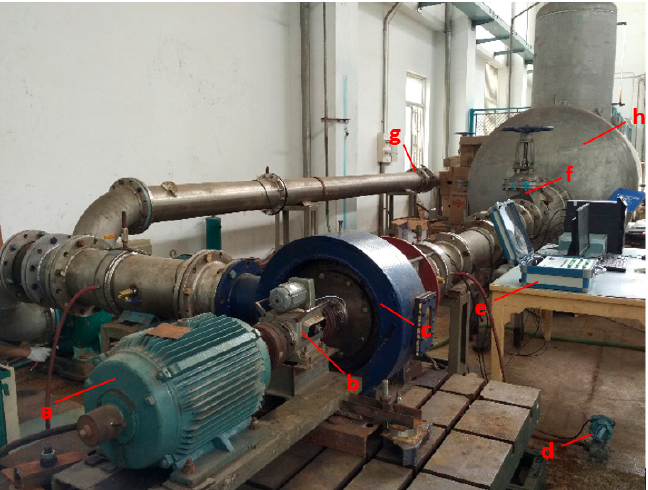
Figure 8. Experimental device ( a ) Motor; ( b ) Torque meter; ( c ) Mixed-flow pump; ( d ) Pressure transmitter; ( e ) HSJ2010 hydraulic machinery comprehensive data acquisition instrument; ( f ) Inlet valve; ( g ) Turbine flow meter; ( h ) Water tank.